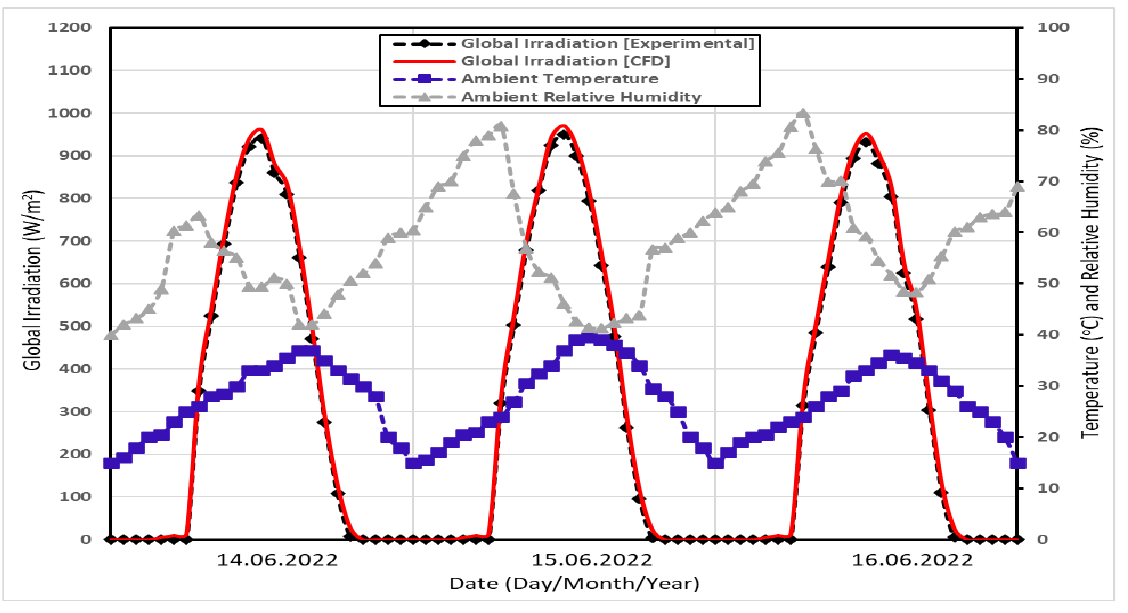
Figure 7. Variations in global irradiance, temperature, and relative humidity of ambient air during experiments.